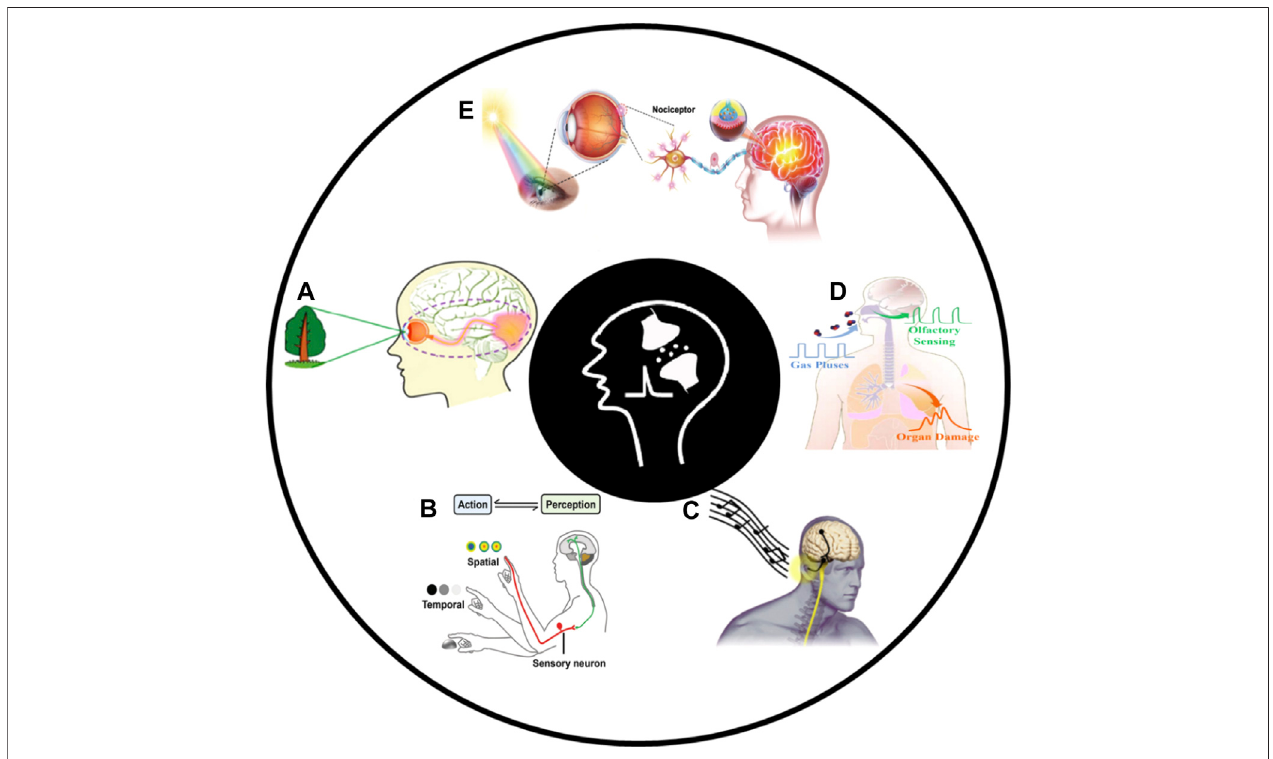
FIGURE 1 | (A) Visual perception (adapted from Gao et al., 2019). (B) Tactile perception (adapted from Wan et al., 2018). (C) Auditory perception (adapted from Seo et al., 2019). (D) Olfactory perception (adapted from Song et al., 2019). (E) Nociceptor Perception (adapted from Feng et al.,